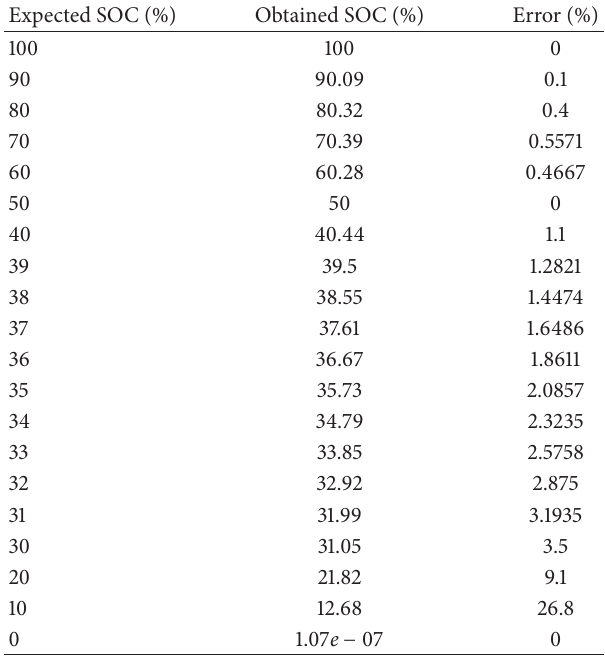
Table 2: Comparison between expected and obtained values of